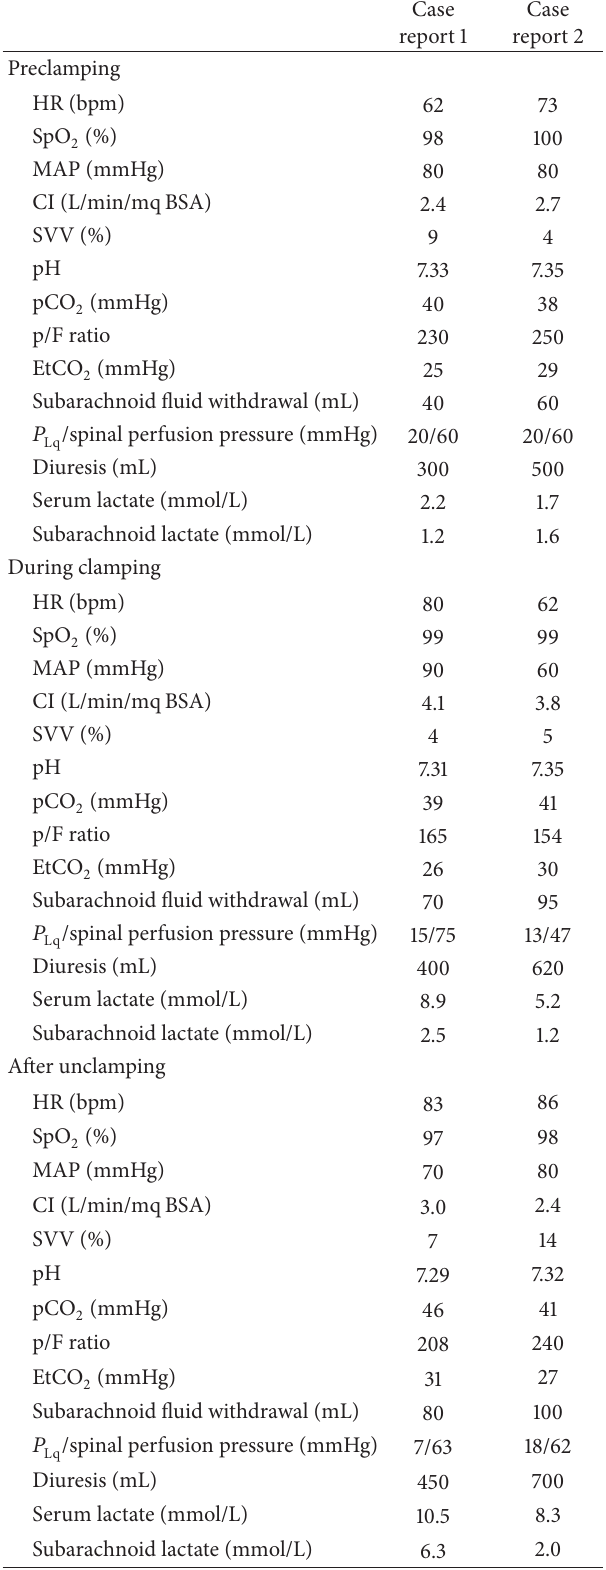
Table 1: Intraoperative